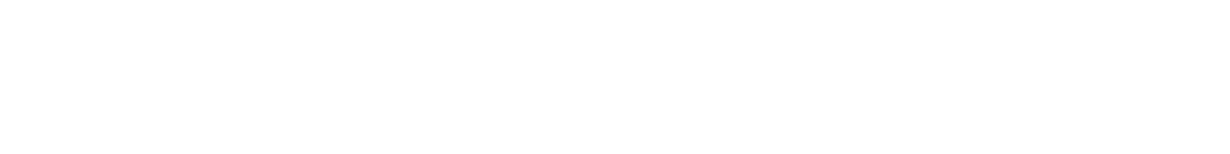
Frontiers in Cell and Developmental Biology |